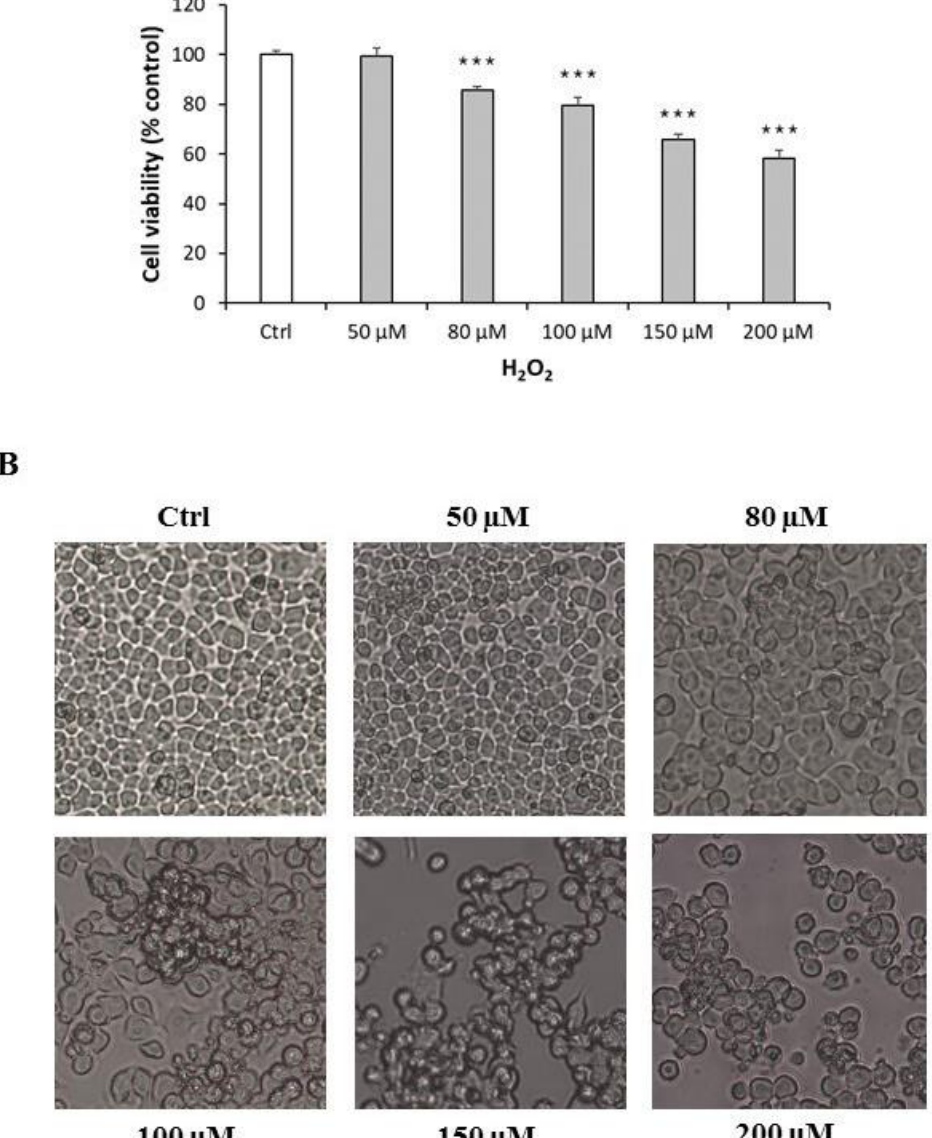
Figure 1. Cytotoxic effect and morphological alterations of Neuro-2A cells in response to increasing concentration of H 2 O 2 . ( A ) Neuro-2A cells were treated for 24 h with different concentrations of H 2 O 2 (0, 50, 80, 100, 150, 200 µ M) and assessed for MTT assay. The assay was performed in at least three independent experiments ( n = 21). Statistical significance: *** p < 0.001 vs. CTRL. ( B ) Morphological changes in Neuro-2A cells were observed by Motic AE2000 Inverted Microscope, at 10 × magnification. Representative images of cells treated with increasing concentration of H 2 O 2 .